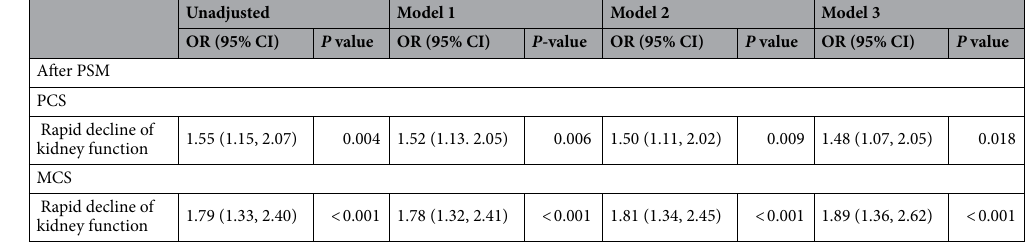
Table 2. Odds ratio of HRQOL decline according to the rapid decline in kidney function. The rapid decline in kidney function was defined as a decline in eGFR of > 3 mL/min/1.73 m 2 /year. Model 1: Adjusted for age, sex, HTN, DM, mean blood pressure, and BMI. Model 2: Model 1 + education, income, and employment. Model 3: Model 2 + hemoglobin, uric acid, albumin, total cholesterol, baseline eGFR, and logUPCR. PSM, propensity score matching; OR, odds ratio; CI, confidence interval; DM, diabetes mellitus; HTN, hypertension; BMI, body mass index; eGFR, estimated glomerular filtration rate by CKD-EPI creatinine equation; UPCR, urine protein- to-creatinine